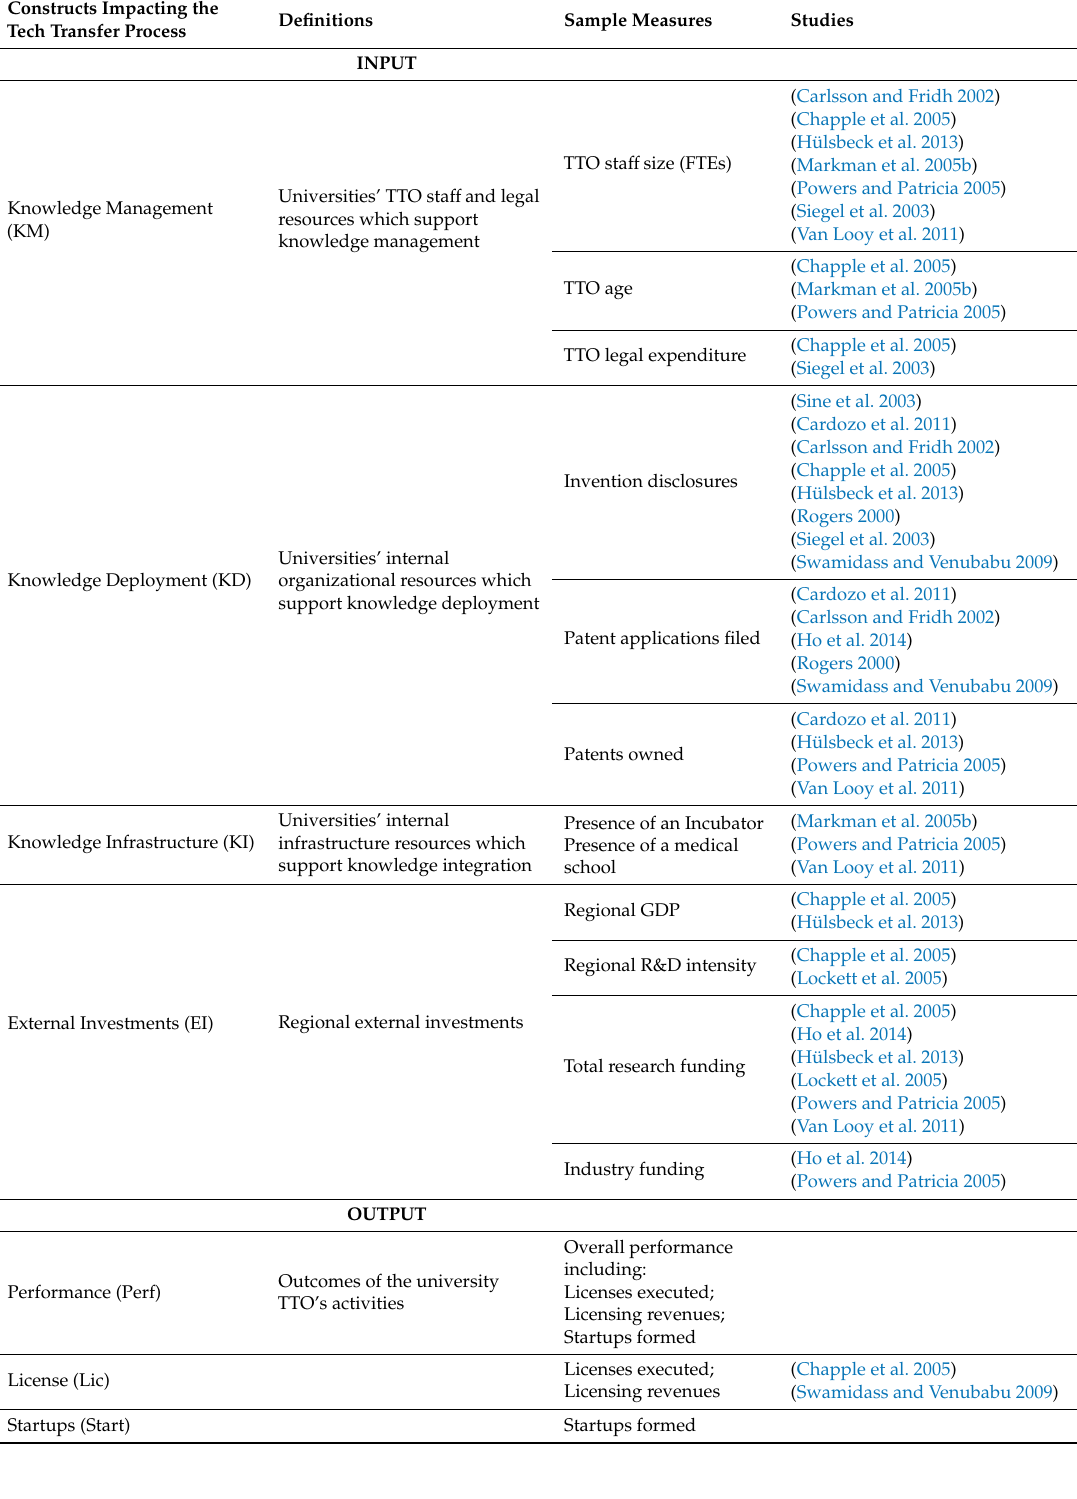
Table 2. Definitions and Sample Measures of KBV